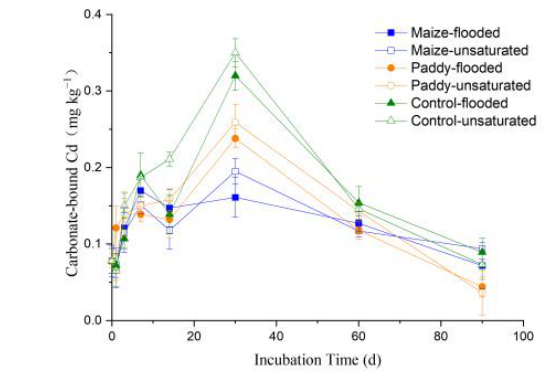
Figure 5. Temporal changes of the content of different Cd fractions (exchangeable Cd ( a ), carbonate-bound Cd ( b ), Fe-Mn oxide-bound Cd ( c ), organic matter-bound Cd ( d ), and residual Cd ( e )) in the soil collected from site A of high pollution levels during laboratory incubation under different treatments.